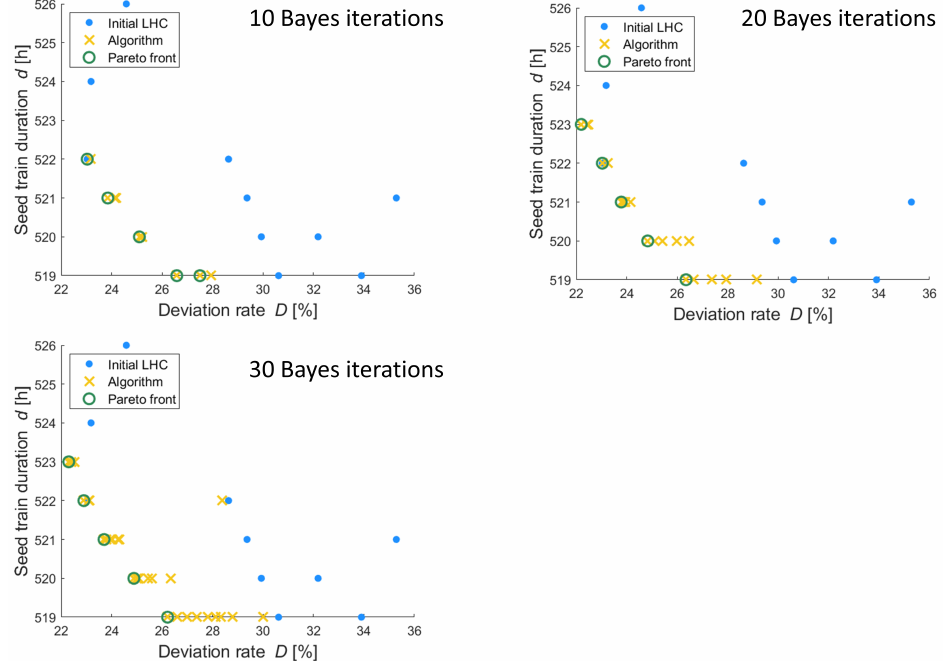
Figure 10. Algorthmically determined solutions and Pareto front of the two objective criteria seed train duration and deviation rate (optimizable variables, here combinations of 3 shake flask filling volumes) for 10 ( top left ), 20 ( top right ) and 30 ( bottom left ) Bayes iterations; blue dots showthe initial Latin hypercube design (LHC); yellow crosses show the points proposed by the algorithm; green circles are the Pareto optimal solutions (=Pareto